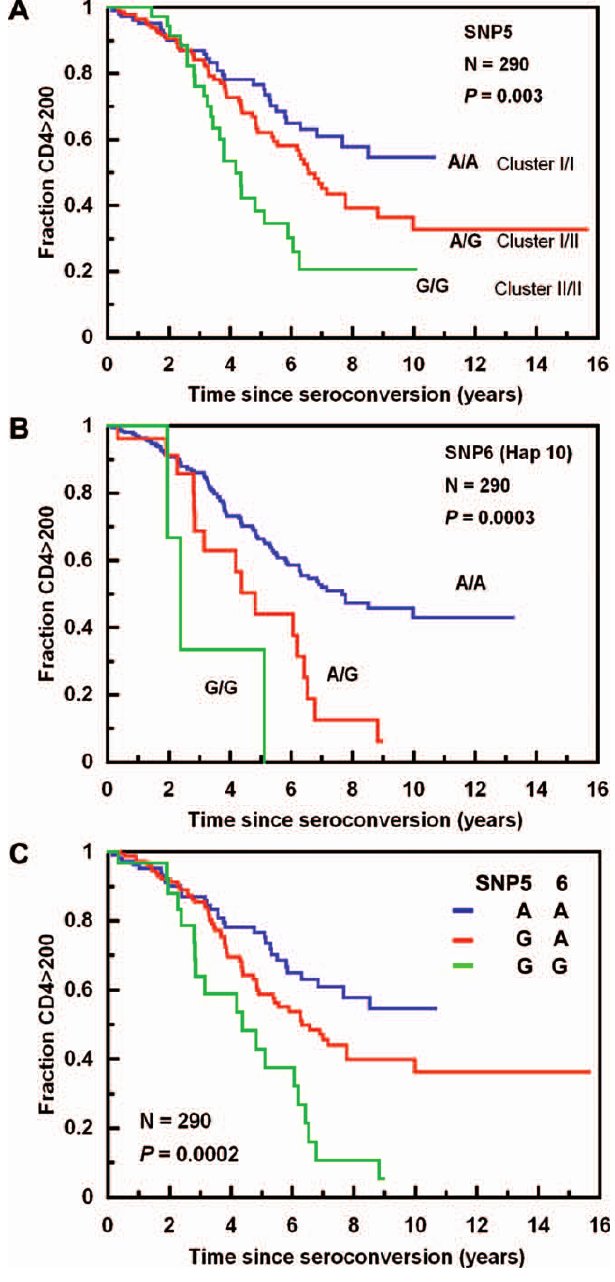
Figure 3. Kaplan-Meier Survival Analysis of CUL5 Variants on Progression from Seroconversion to CD4 þ T cells , 200 /mm 3 in AA (A) Shows ctSNP5 (the cluster); (B) shows htSNP6 (Hap10); and (C) shows compound genotypes of ctSNP5 and htSNP6.